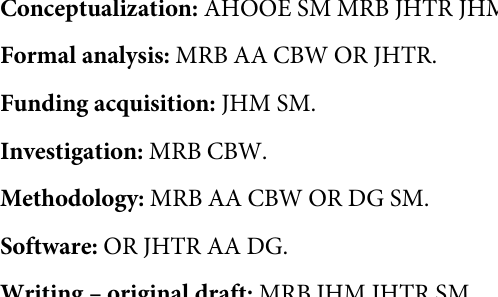
S2 Fig. Effect of photoperiod on PER2::LUC rhythm recorded with 14.5 min exposure time. (A) Average peak time of PER2::LUC rhythms are shown for the anterior and posterior SCN in LP (green squares) and SP (red circles). Peak time is plotted as external time (ExT). Dark period of the previous light regime are represented by grey background (cf Fig 1C). (B) Peak time distribution is defined as the standard deviation (SD) of the peak times per slice (cf. Fig 2B). (C) Period variability is defined as the SD of the period first three cycles in vitro per cell, and averaged per slice (cf. Fig 3B). (D) Correlation of the peak time SD and Period SD from all data of this set (cf. Fig 3C). Black bars indicate mean ± SEM. S3 Fig. Time in culture does not affect photoperiodic induced difference in phase dispersal. Peak time distribution (SD) was calculated as a measure for phase dispersal for the first three days in culture. Photoperiod effect on phase dispersal did not alter during the time in culture. S4 Fig. Period of the PER2::LUC expression rhythms. Period was determined over three cycles and averaged per slice, for (A) the experiments with 14.5 minutes exposure time, (B) 29 minutes exposure time. Black bars indicate mean ± SEM. S5 Fig. Cycle-to-cycle jitter in cells is larger in long photoperiod. Examples of PER2::LUC bioluminescence of six cells in LP (left) and SP (right) are shown, where the detrended signal of each individual cell (red) is compared to a sinusoid wave with the average period of the same cell (blue). The detrended signal is obtained by first smoothing the raw data. Then a fourth-order polynomial trend line was derived from the smoothed signal and subsequently subtracted. The sinusoidal signal was aligned to the half-maximum value of the rising edge of the first cycle. The time difference of the half-maximum values of the rising edge of subsequent cycles between the detrended data and the sinusoid represents the jitter in cycle-to-cycle inter- val. For each example, the number of the cell is shown in the upper right corner. Time is speci- fied in